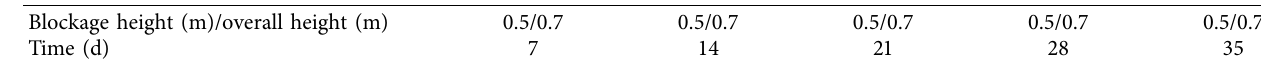
Table 4: Test parameter table for different blocking